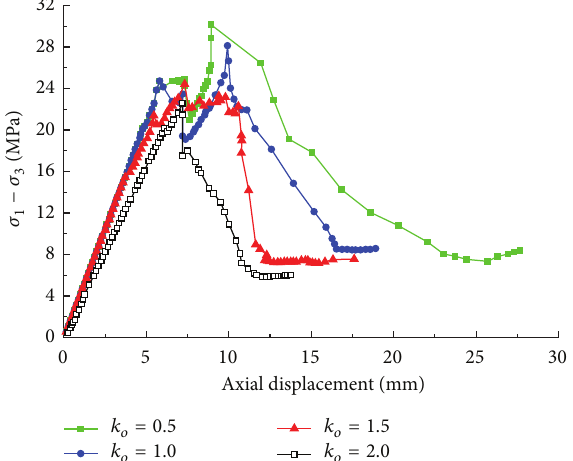
Figure 21: Variations of principal stress difference with axial displacement for various pressures ratios, 𝑘 𝑜 .